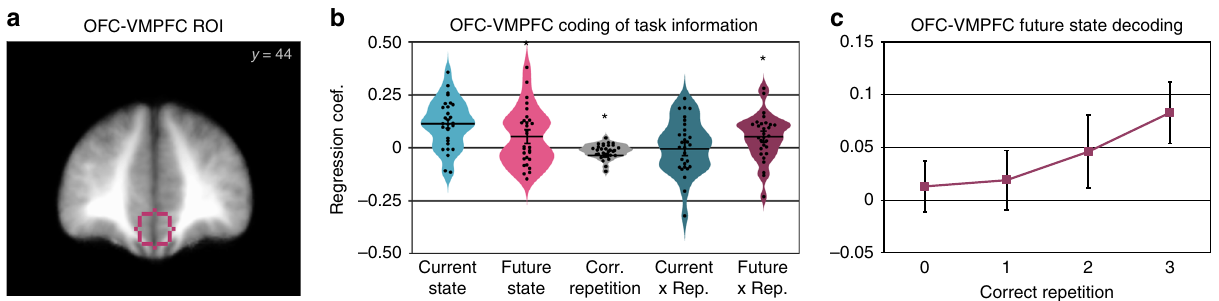
Fig. 3 Multivariate OFC-VMPFC responses at state 1 onset related to the representation of anticipated future states. a Outline of the OFC-VMPFC region of interest shown over the across-participant average anatomical MRI. b Regression coef fi cients for decoded activity in the OFC-VMPFC for the current state (state 1), future state (state 3), the repetition since performance was correct, the interaction of current state with correct repetition, and the critical interaction of future state with correct repetition. Distribution density is represented by violin plot width; individual participant datapoints are in black. (* p < 0.05, t test; error bars represent standard error of the mean; statistical comparisons were not completed on the current state representation in ( b ) because the plotted data represent the results after exclusion of two participants with poor decoding during learning.) c Breakdown of the future state by correct repetition interaction, for illustration. Future state classi fi cation is plotted separately for each correct maze repetition; these effects were derived from control models examining current and future state separately for each correct repetition